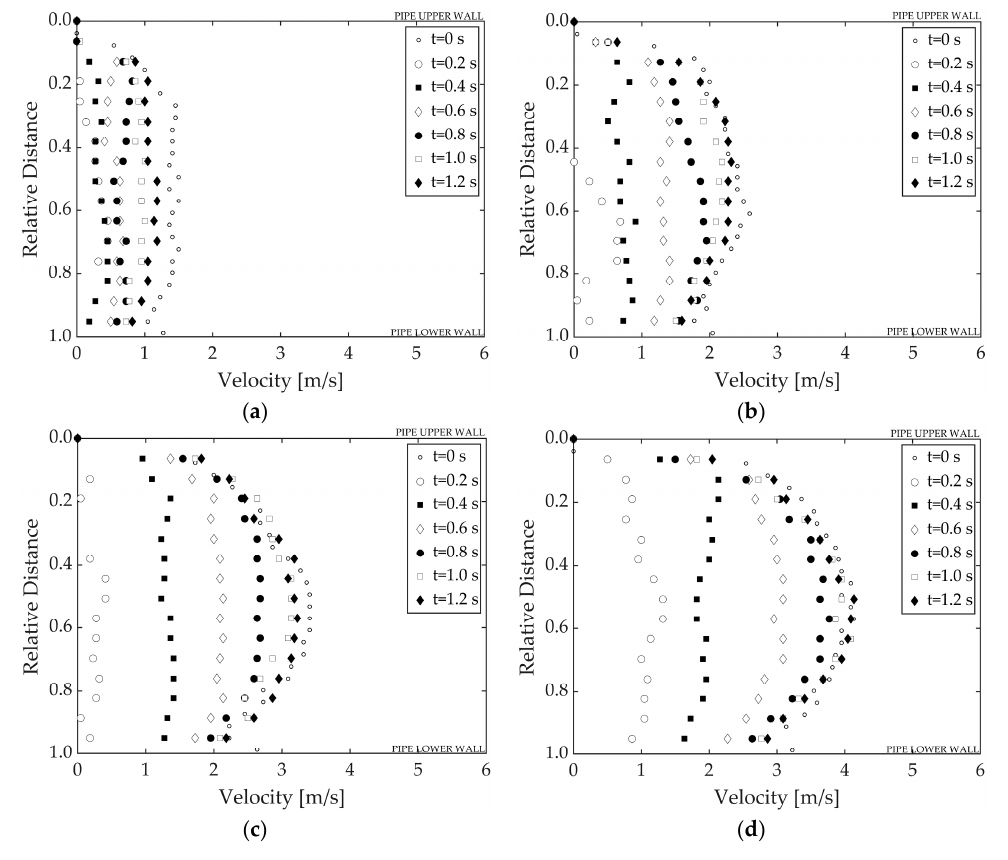
Figure 9. Velocity profiles along time: ( a ) Re =58,000; ( b ) Re =93,000; ( c ) Re =132,000; ( d ) Re =155,000.